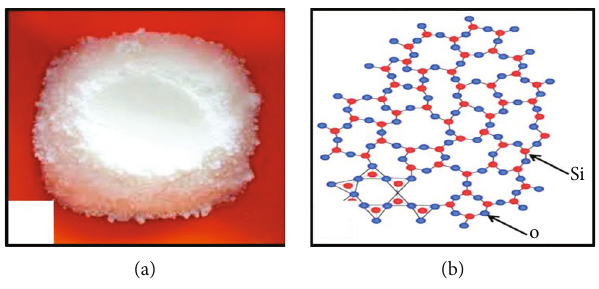
Figure 2: (a) Photographic image of nanosilica powder. (b) Chemical structure of silica. Table 2: Stacking sequence arrangement of nanocomposites. Sl.